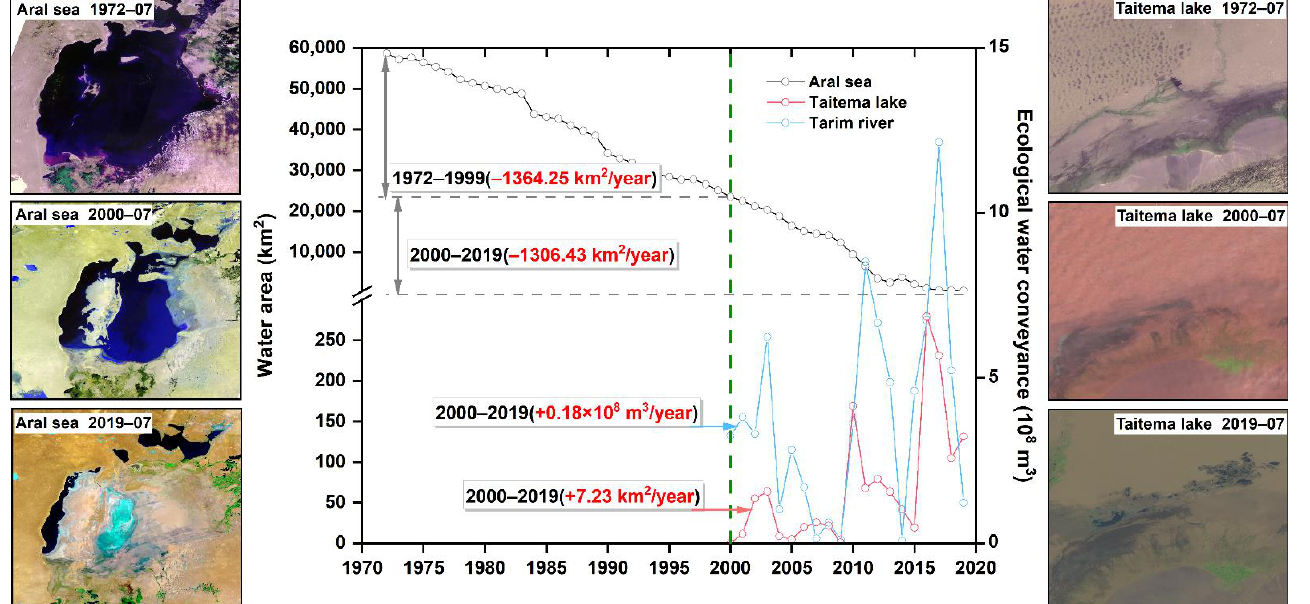
Figure 2. Spatial and temporal variation of water resources in the Aral Sea and Taitema Lake, Central Asia, before and after EWC to the Tarim River.